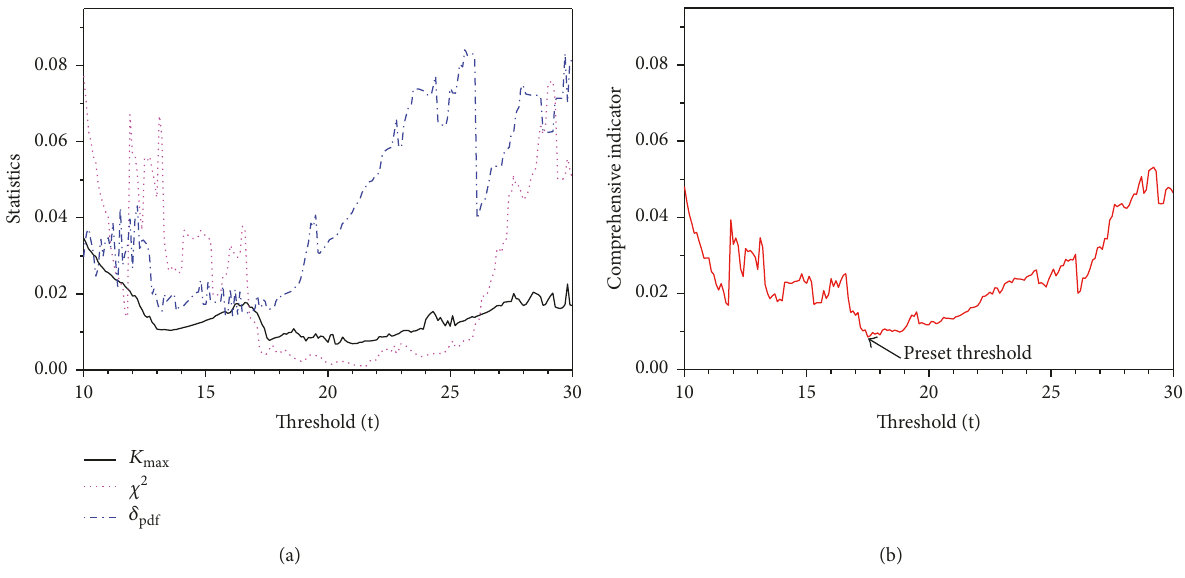
Figure 4: Goodness-of-fit test: (a) single criteria and (b) multiple criteria.